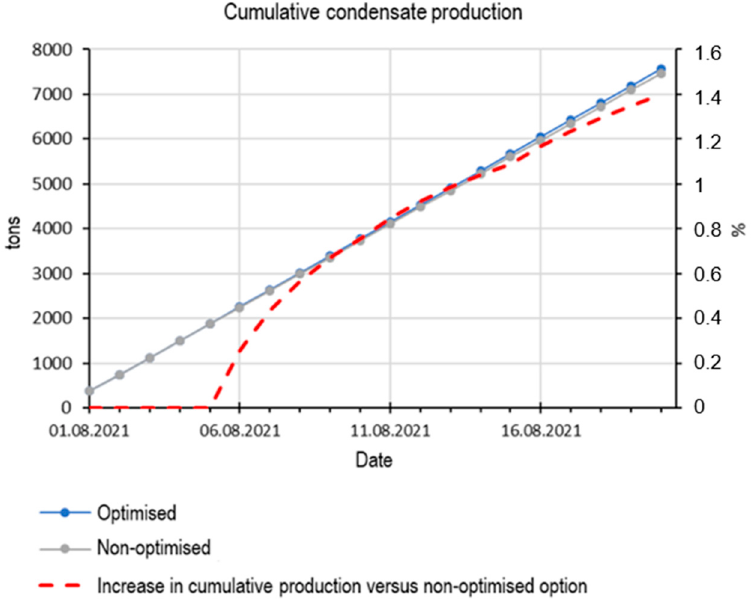
Figure 5. Cumulative condensate production for 20 days with 3-step optimization. The difference between two options (optimized and non-optimized) shown by the red dashed line has its own vertical axis on the right side of the plot (percentage points were used here).